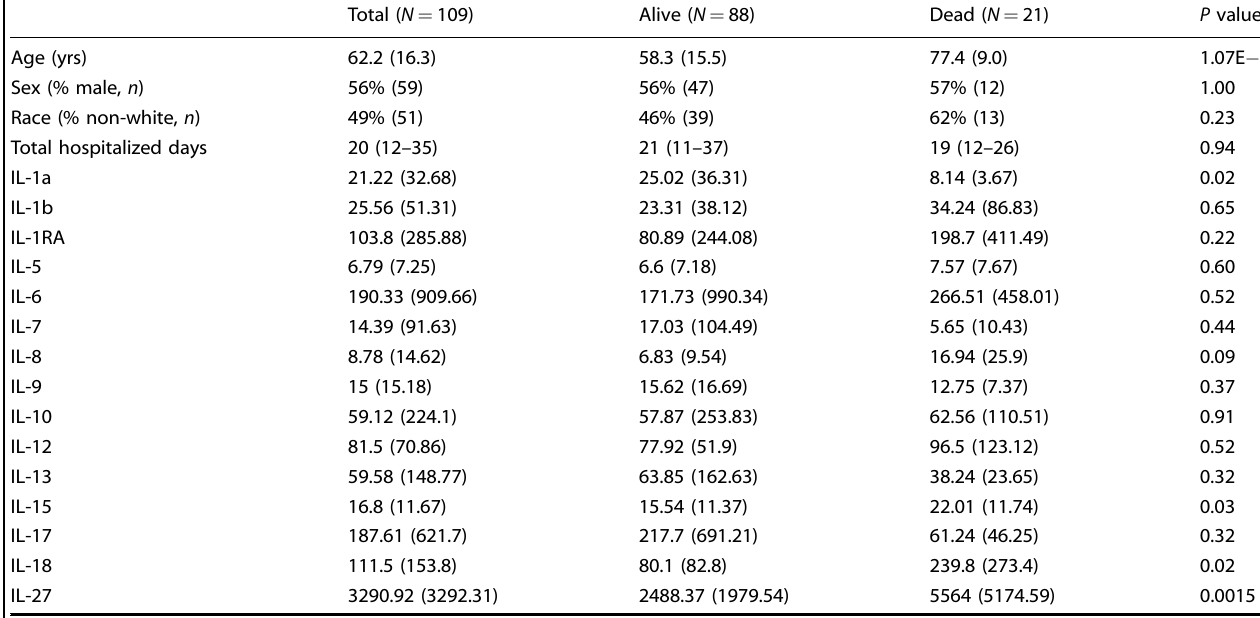
Table 1. Demographic and cytokine data of IU COVID-19 cohort